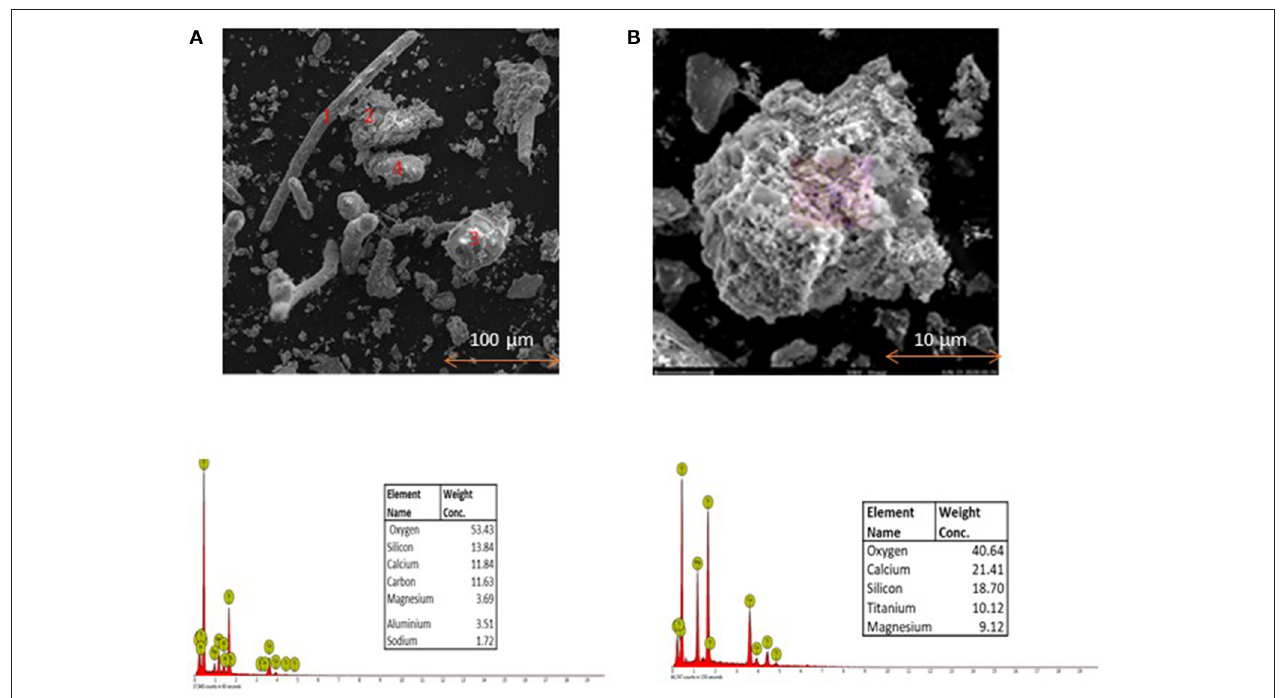
FIGURE 7 | Scanning Electron Micrograph (A) . Combined analysis (B) . An individual particle of ASR pyrolysis solid residue obtained at 500 ◦ C.